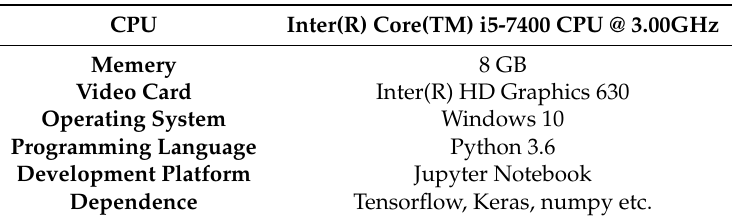
Table 1. The environment of all experiments.